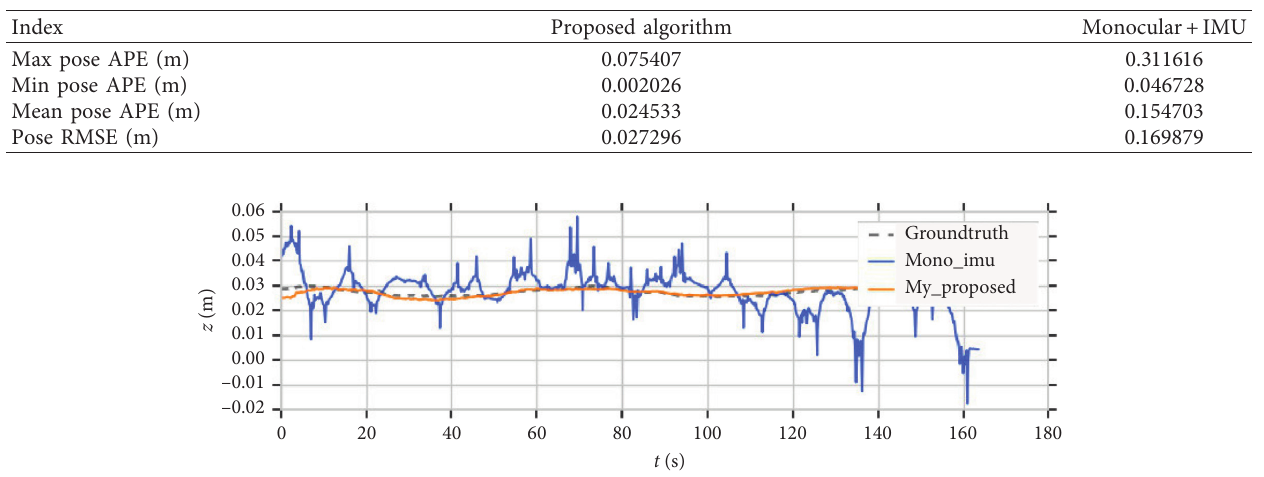
Figure 7: Comparison of z -axis with true